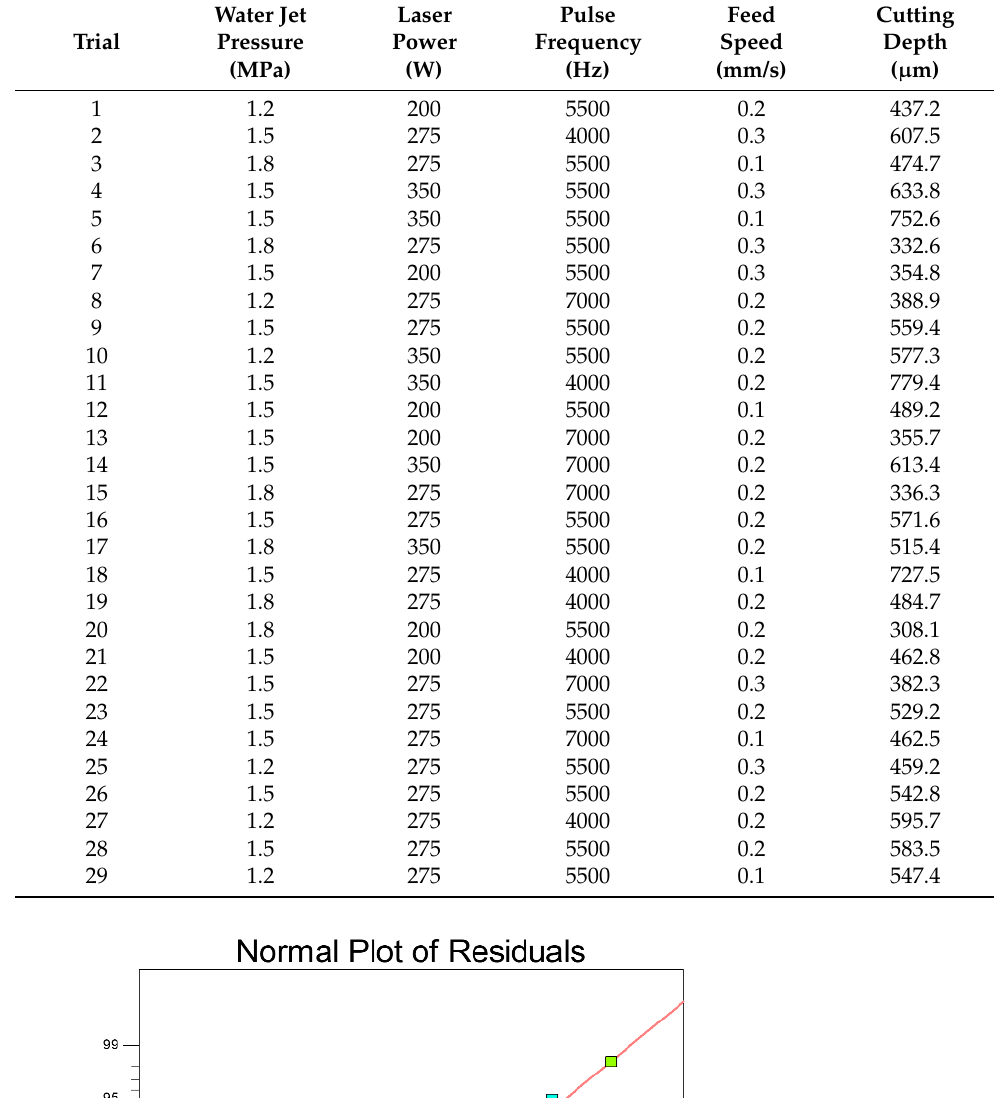
Table 6. RSM experimental results.